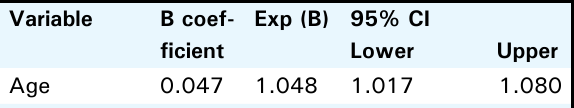
Table 3. Logistic regression model for